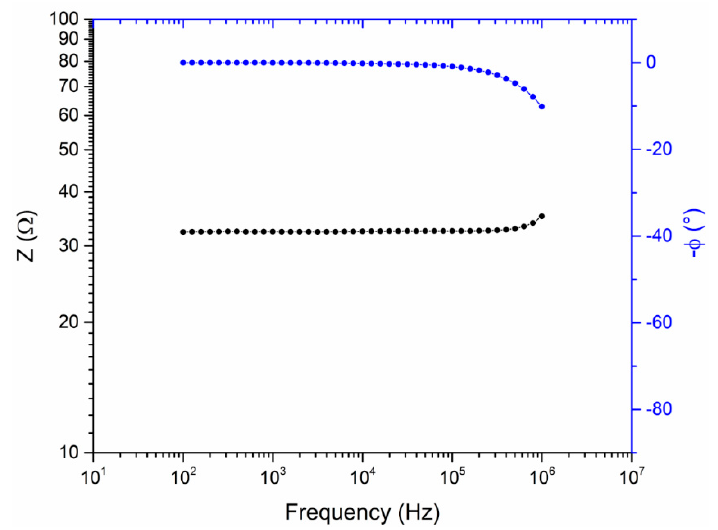
Figure 10. Bode Plot of the graphene sample. Black curve represents the amplitude of the impedance (vertical axis on the left). Blue curve represents the phase of the impedance (vertical axis on the right). At high frequencies some distortions due to the experimental setup.